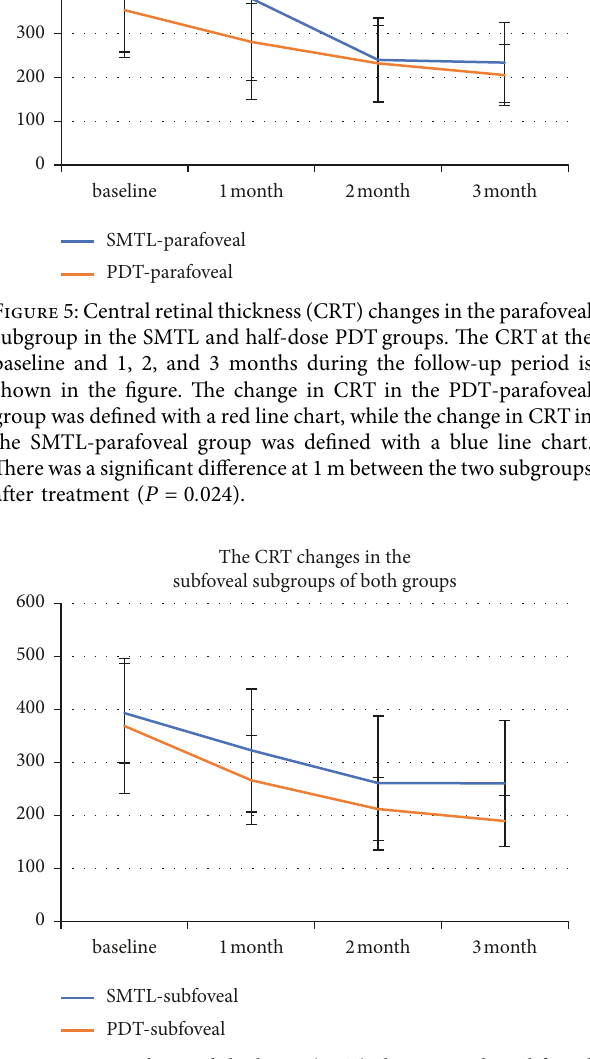
Figure 6: Central retinal thickness (CRT) changes in the subfoveal subgroup in the SMTL and half-dose PDT groups. The CRT at the baseline and 1, 2, and 3 months during the follow-up period is shown in the figure. The change in CRT in the PDT-subfoveal group was defined with a red line chart, while the change in CRTin the SMTL-subfoveal group was defined with a blue line chart. There was a significant difference at 1. 3m between the two subgroups after treatment ( P 0 . 03, (cid:31)